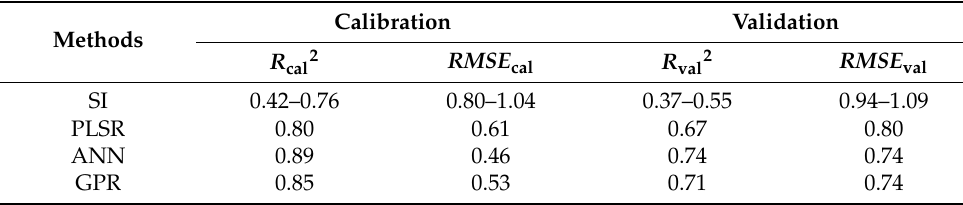
Table 5. Summary of results from different LAI prediction methods used in this study.